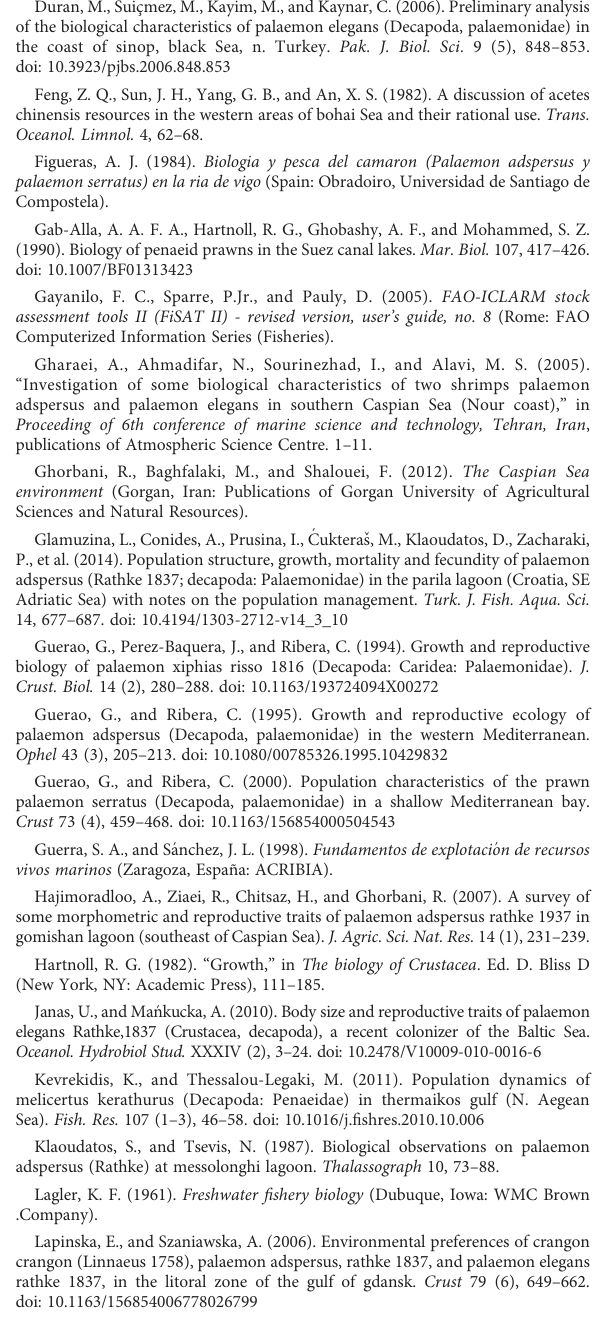
Figueras, A. J. (1984). Biologia y pesca del camaron (Palaemon adspersus y palaemon serratus) en la ria de vigo (Spain: Obradoiro, Universidad de Santiago de